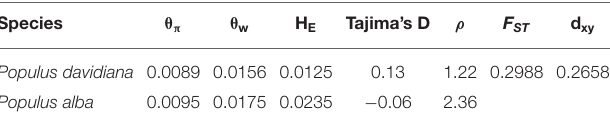
TABLE 5 | Mean ( ± standard deviation) values of population genomic statistics ( θ π , θ w, H E , Tajima’s D, ρ , F ST and dxy) comparisons between P. davidiana and P. alba